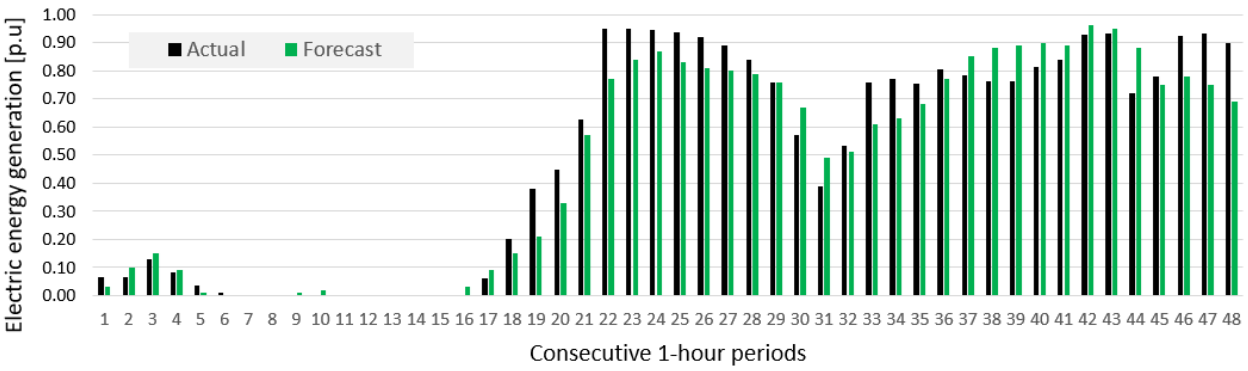
consecutive days of the winter month (January).